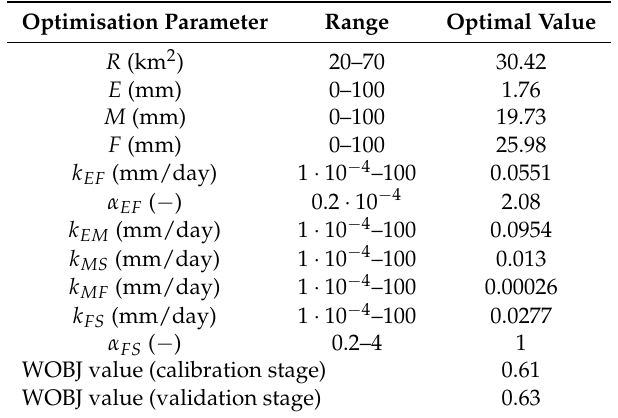
Table 3. Ranges of parameter values carried out by the optimisation procedure based on the discharge hydrograph of Golubinka spring and the optimal values of the parameters used for